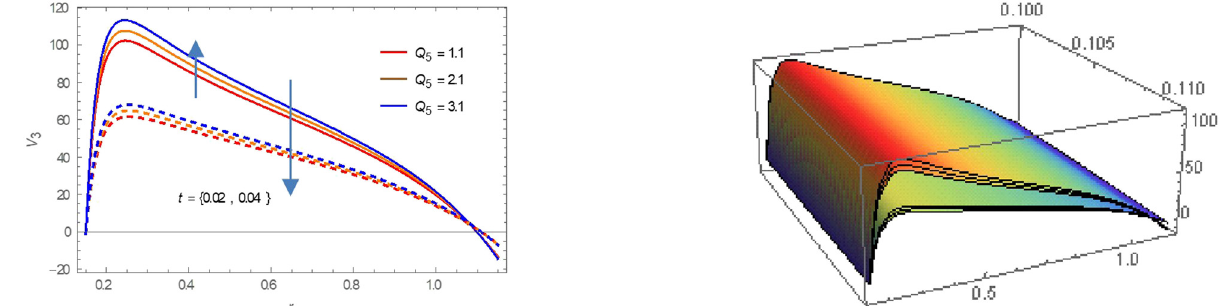
Figure 6: Distribution of velocity for di ff erent values of t and Q 5 with